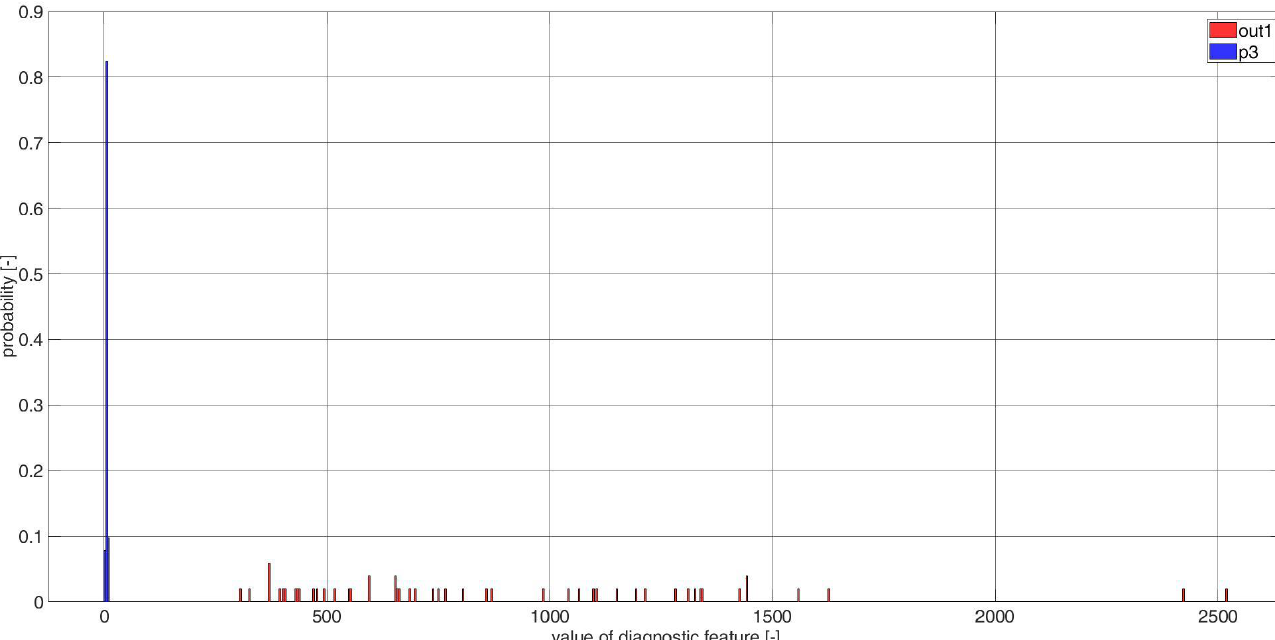
Figure A29. Histograms of diagnostic features based on the CCSM3 (correlation number is 2 — Table A2) bearings out1 and p3.